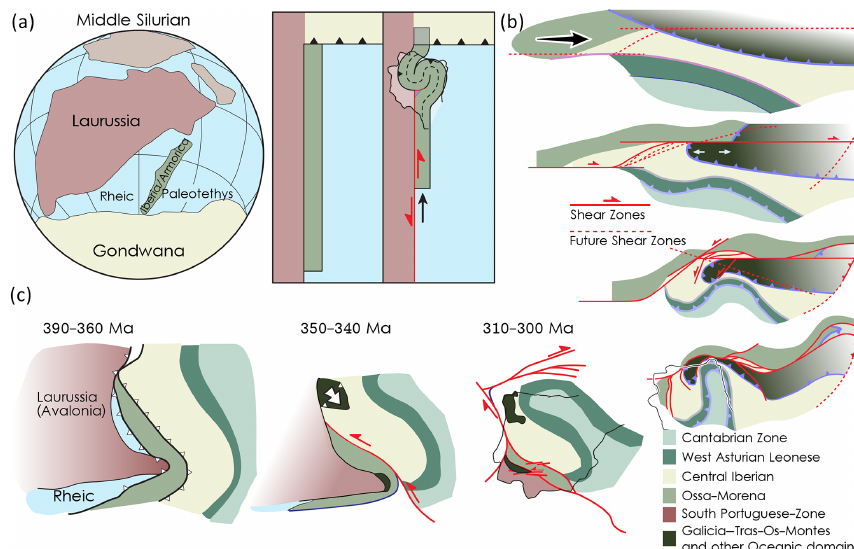
Figure 11. Pioneering hypotheses for the Central Iberian curve. Note that none of them fulfill the most recent geometric and kinematic criteria. (a) Simplified ribbon continent model from Johnston et al. (2013) and Shaw and Johnston (2016). (b) Dextral mega-shear model from Martínez Catalán (2011). (c) Kinematic model with indentation and left-lateral shearing from Simancas et al.